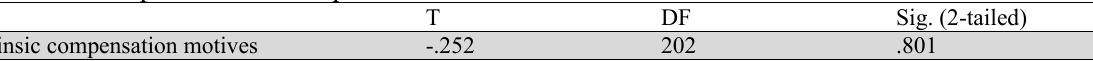
Independent Sample Test for Compensation Motives